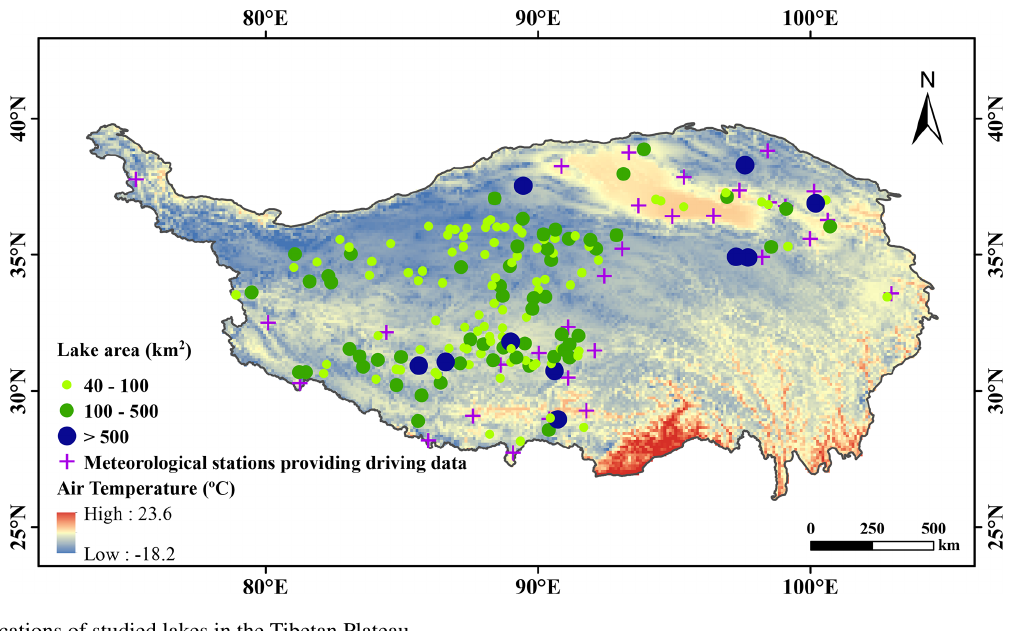
Figure 1. Locations of studied lakes in the Tibetan Plateau.